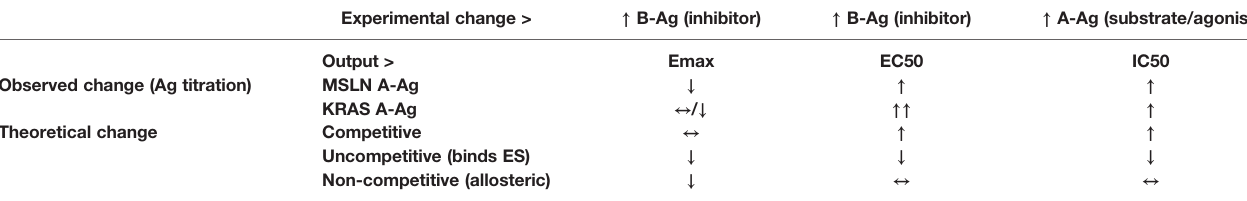
TABLE 3 | Observed vs. theoretical behavior (by model type) of Tmod system according to pharmacologic models. Experimental change